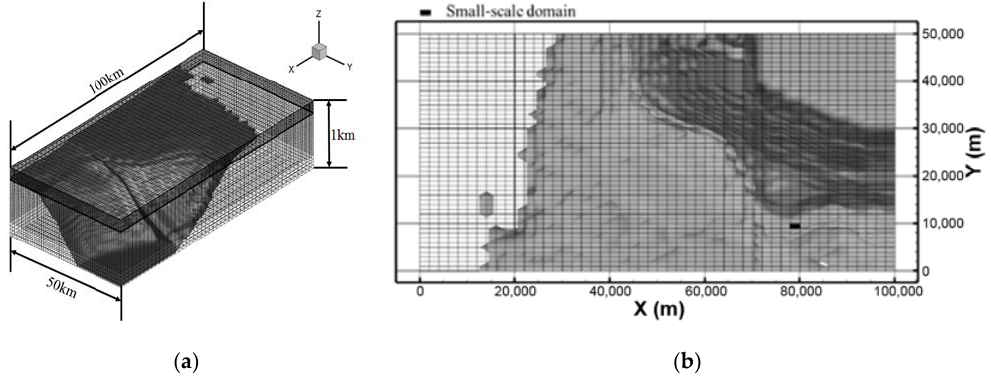
Figure 2. ( a ) Perspective and ( b ) horizontal view of grid systems (one cell filled with black color in the mesoscale domain is the computational domain for the full-3D small-scale domain). Table 1. Layer numbers, thicknesses, and depths of vertical grids.